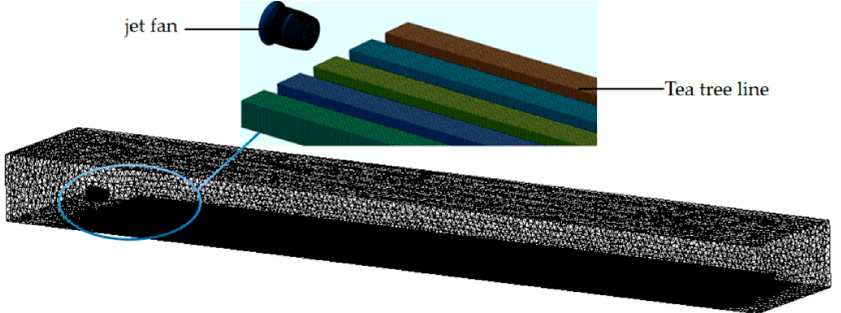
Figure 8. Grid generation results.